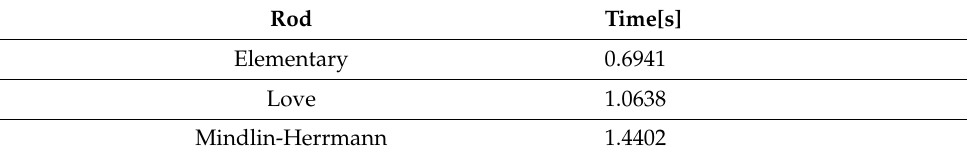
Table 1. Computational processing time for each rod.